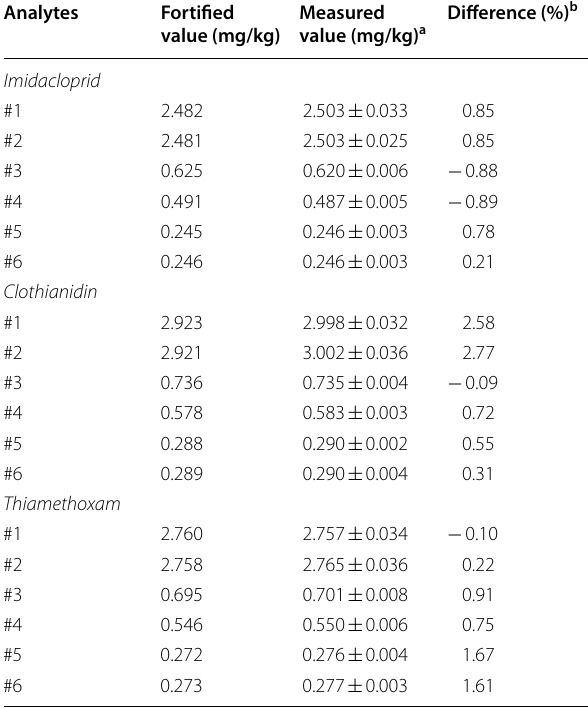
Table 1 Measurement results of gravimetrically fortified samples to kimchi cabbage powder by ID-LC/MS/MS at various mass